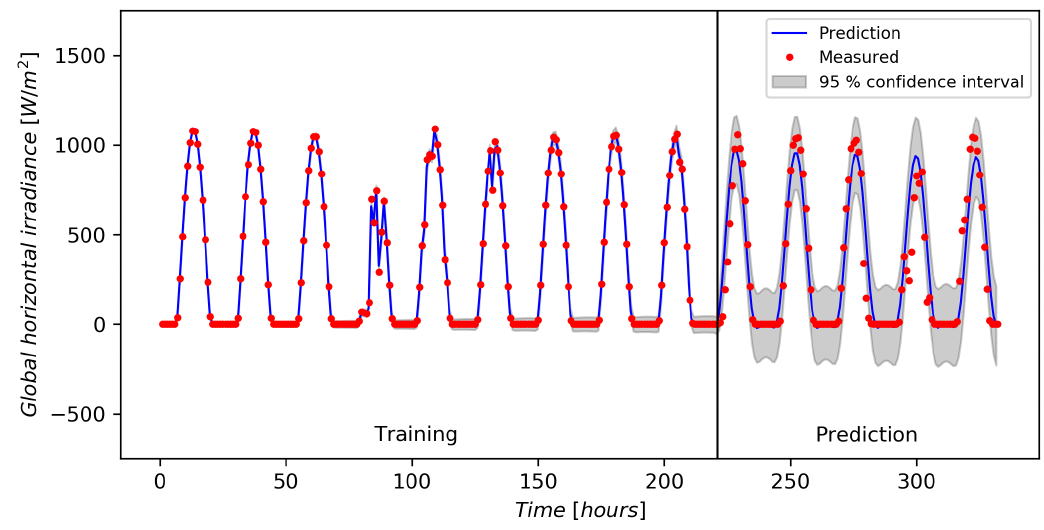
Figure 10. Gaussian process forecast using a periodic kernel times a rational quadratic